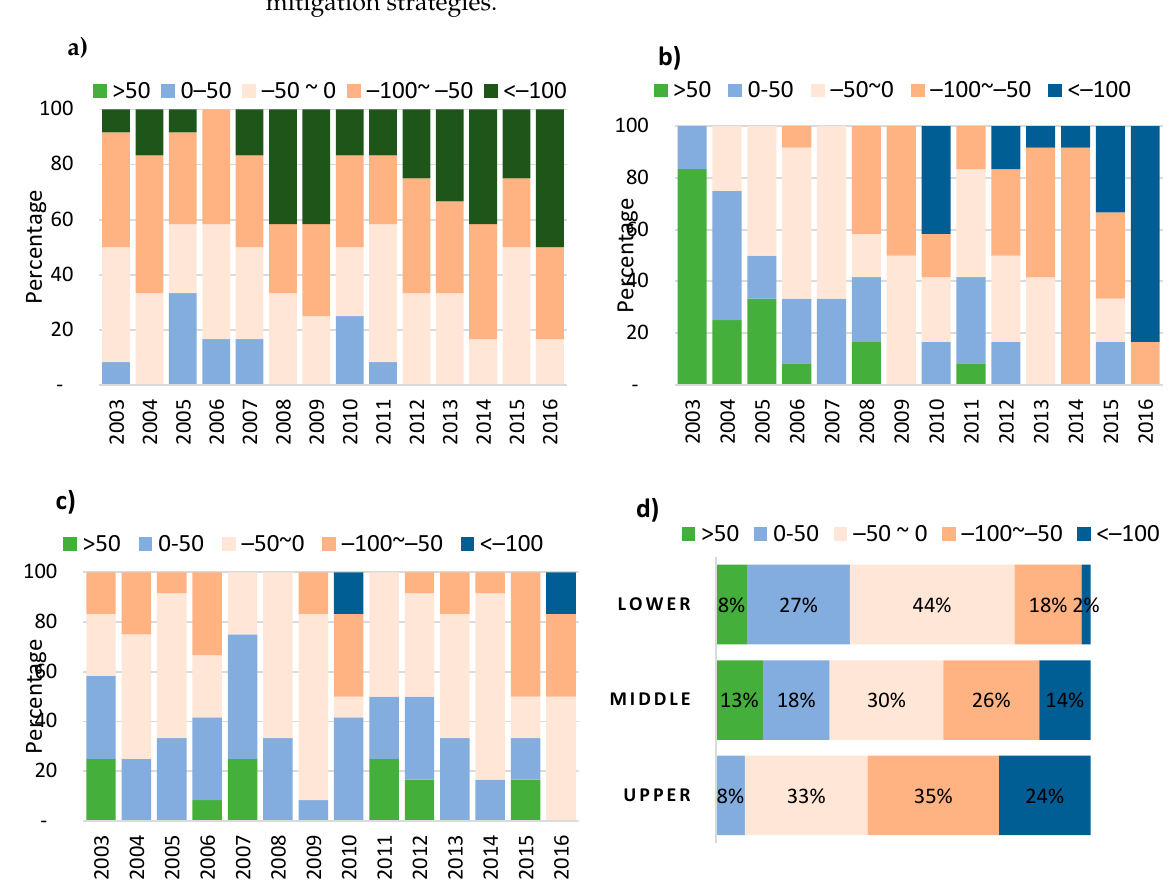
Figure 9. ( a ) Upper reach groundwater changes, ( b ) middle reach groundwater changes, ( c ) lower reach groundwater changes, and ( d ) annual severity of GWCs in the different reaches of IRB.